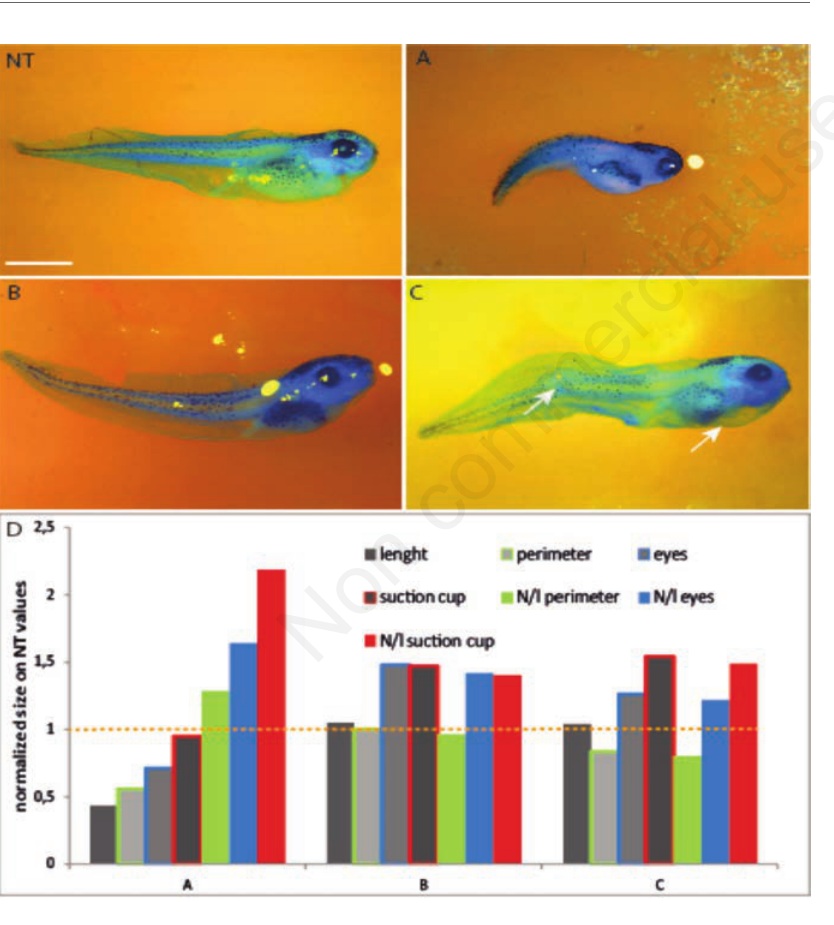
Figure 2. Biometric analysis of 4 different tadpoles. NT corresponds to non-treated ani- mal while A-C are tadpoles grown in contaminated environment. White arrows illustrate some of the morphological defects enlightened by the image improvement step. D cor- responds to biometrical quantification from A-C normalized on measurements per- formed on NT, with: i) length and perimeter; ii) eyes, corresponding to the distance between the both animal’s eyes centroids in ventral position; iii) suction cup correspon- ding to the distance between the isobarycenter of both eyes and the suction cup. N/l stands for the parameters also normalized on the length of the concerned animal. Doted orange line corresponds to NT. Scale bar 1